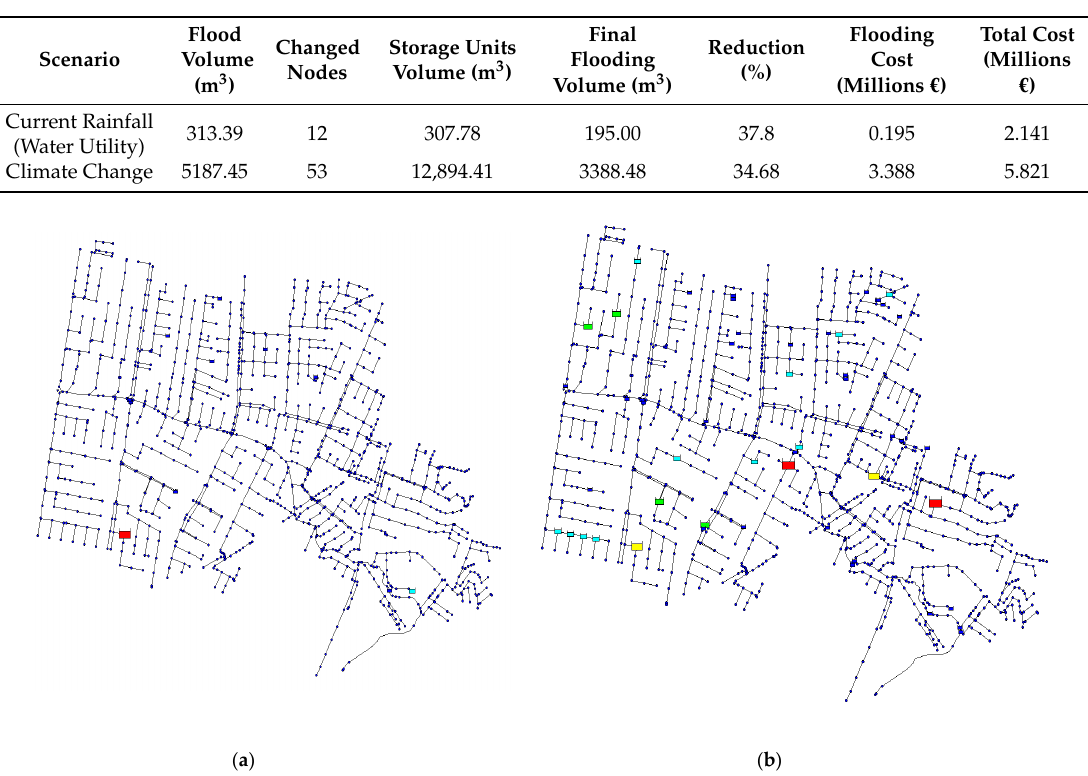
Figure 11. Results for the stormwater tank locations using OptiTank. The colors represent the size of the stormwater tank where red is the largest followed by yellow, green and cyan. ( a ) Results considering the current rainfall scenario. ( b ) Results considering the Climate Change effects on rainfall.